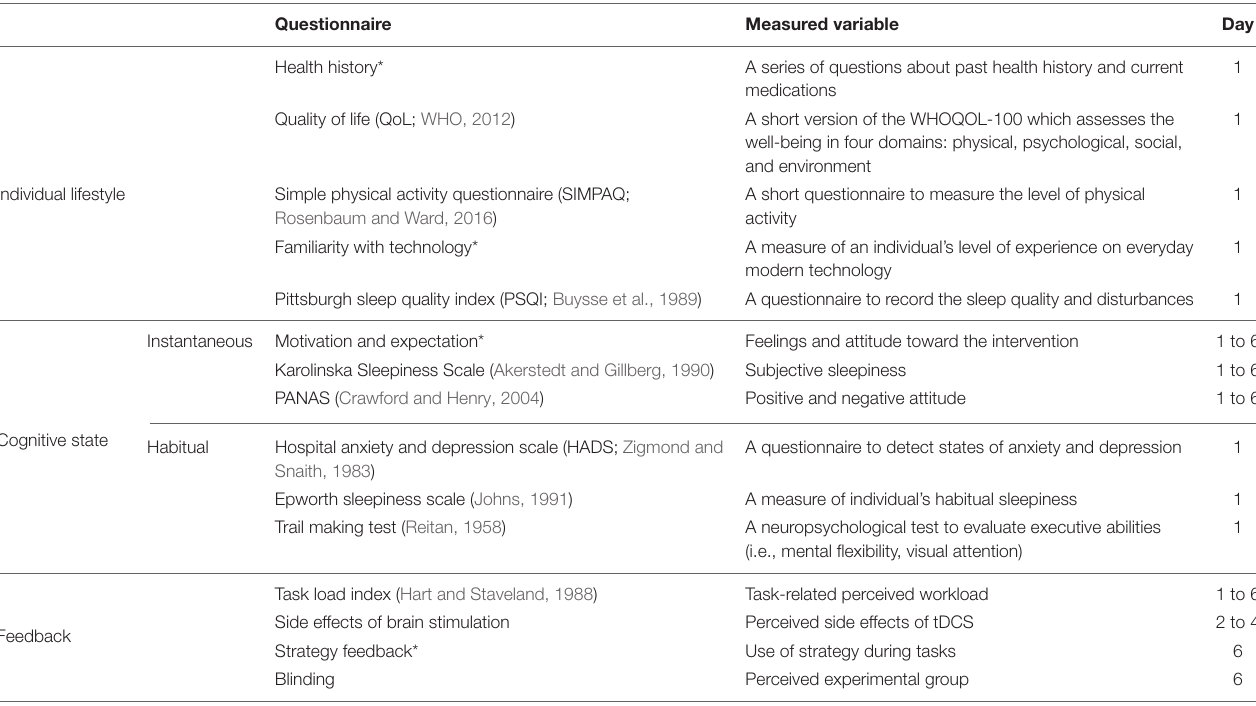
TABLE 2 | Description of the questionnaires administered to